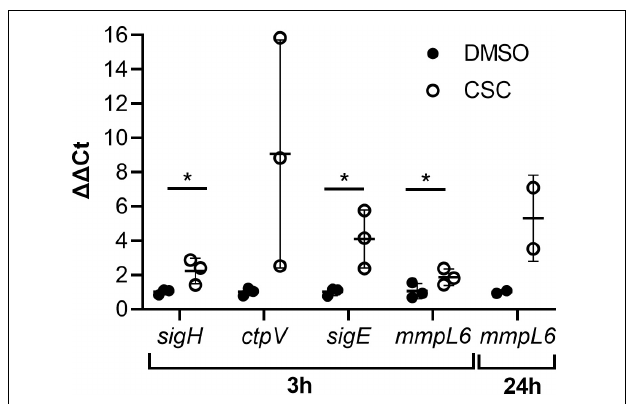
FIGURE 3 | Expression levels of selected genes confirmed by RT-qPCR. The (cid:49)(cid:49) Ct values are indicated ( n = 3) and were calculated relative to the housekeeping gene, sigA . SigA was shown to be consistently expressed in the RNA-seq analysis. Multiple unpaired, one-tailed t -tests were done, and p ≤ 0.05 was considered statistically significant ( sigH at 3 h: DMSO vs. CSC, p = 0.049; ctpV at 3 h: DMSO vs. CSC, p = 0.086; sigE at 3 h: DMSO vs. CSC, 0.043; mmpL6 , 3 h, DMSO vs. CSC, 0.048, 24 h, p = 0.125). * p <